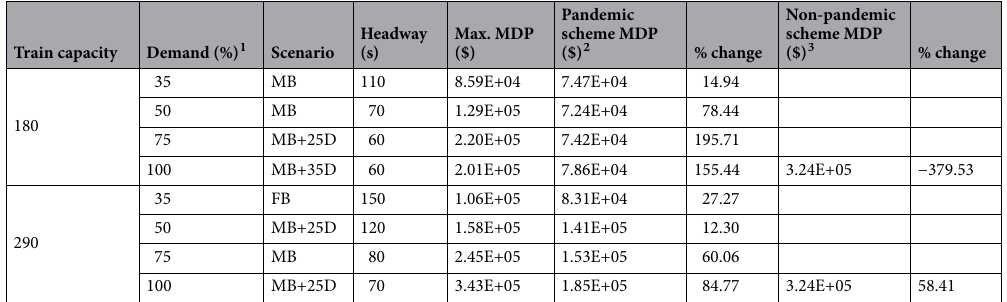
Table 1. Best performing scenario vs regular operations, baseline crowding multiplier of 1. MB base moving block, MB+25D moving block with 25 s minimum dwell time, MB+35D moving block with 35 s minimum dwell time, FB fixed block. 1 Demand is reported as a percentage of 2019 demand levels, 2 The scheme used during the pandemic is the base moving block and 100 s headway, 3 The scheme used during non-pandemic times is the base moving block and 100 s headway with a 1000 passenger train